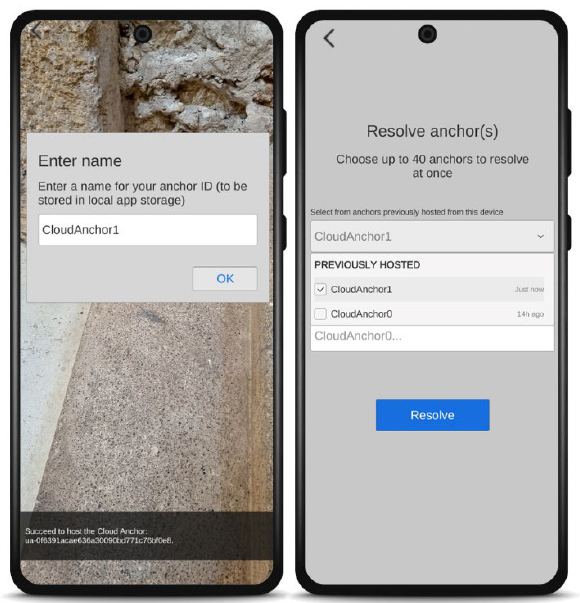
Figure 8. Left: The app used by the AR operator to name the anchor. Right: The app used by the end user to retrieve the anchor.